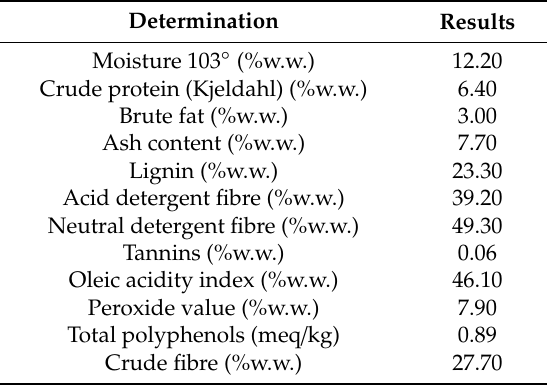
Table 1. Fermented defatted “alperujo” (FDA) composition.